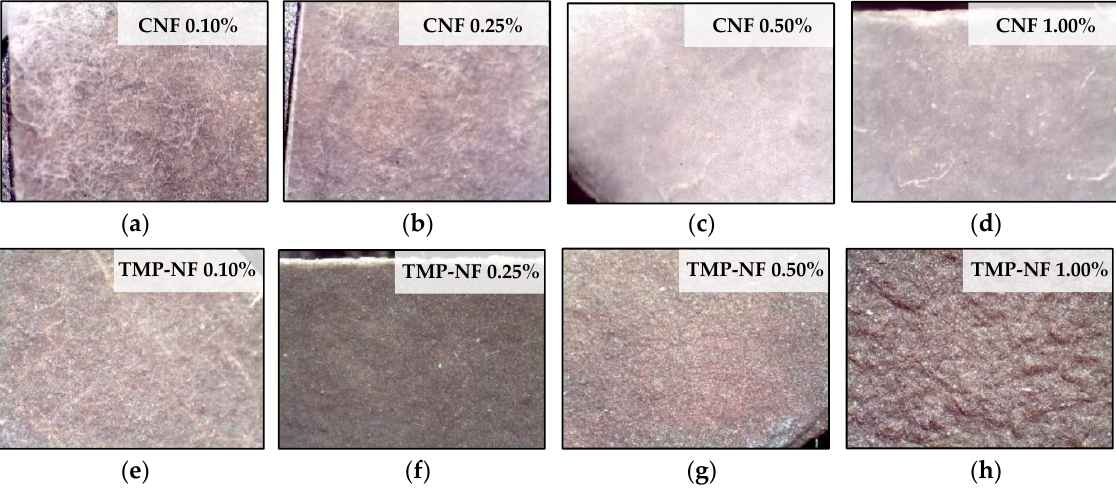
Figure 9. Stereo Microscope images (35×) for all developed films. ( a ) CNF 0.10%; ( b ) CNF 0.25%; ( c ) CNF 0.50%; ( d ) CNF 1.00%; ( e ) TMP-NF 0.10%; ( f ) TMP-NF 0.25%; ( g ) TMP-NF 0.50%; ( h ) TMP-NF 1.00%.